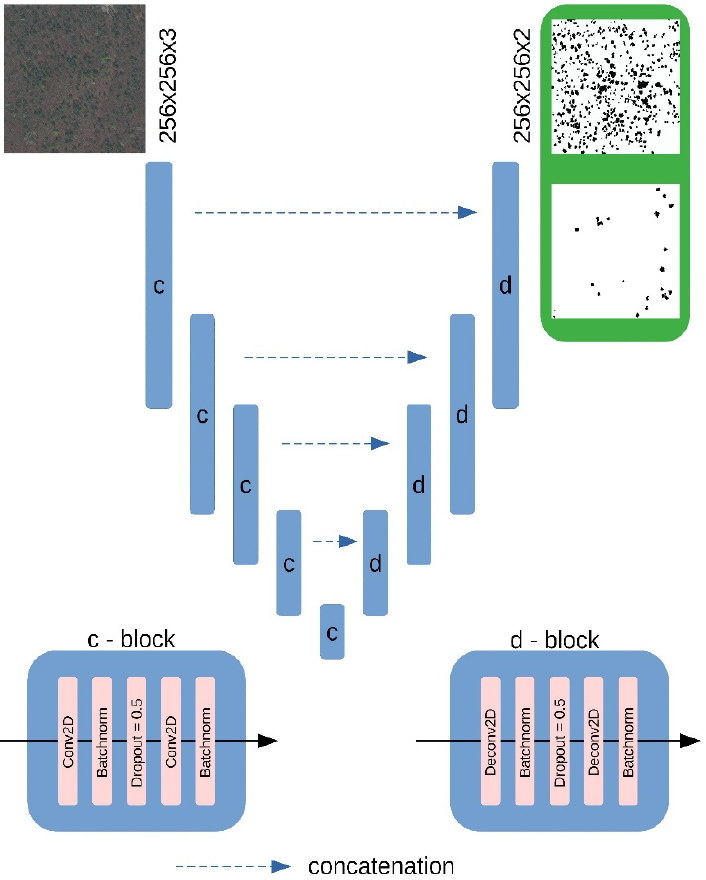
Figure 2. The U-Net-like convolutional neural network (CNN) architecture.